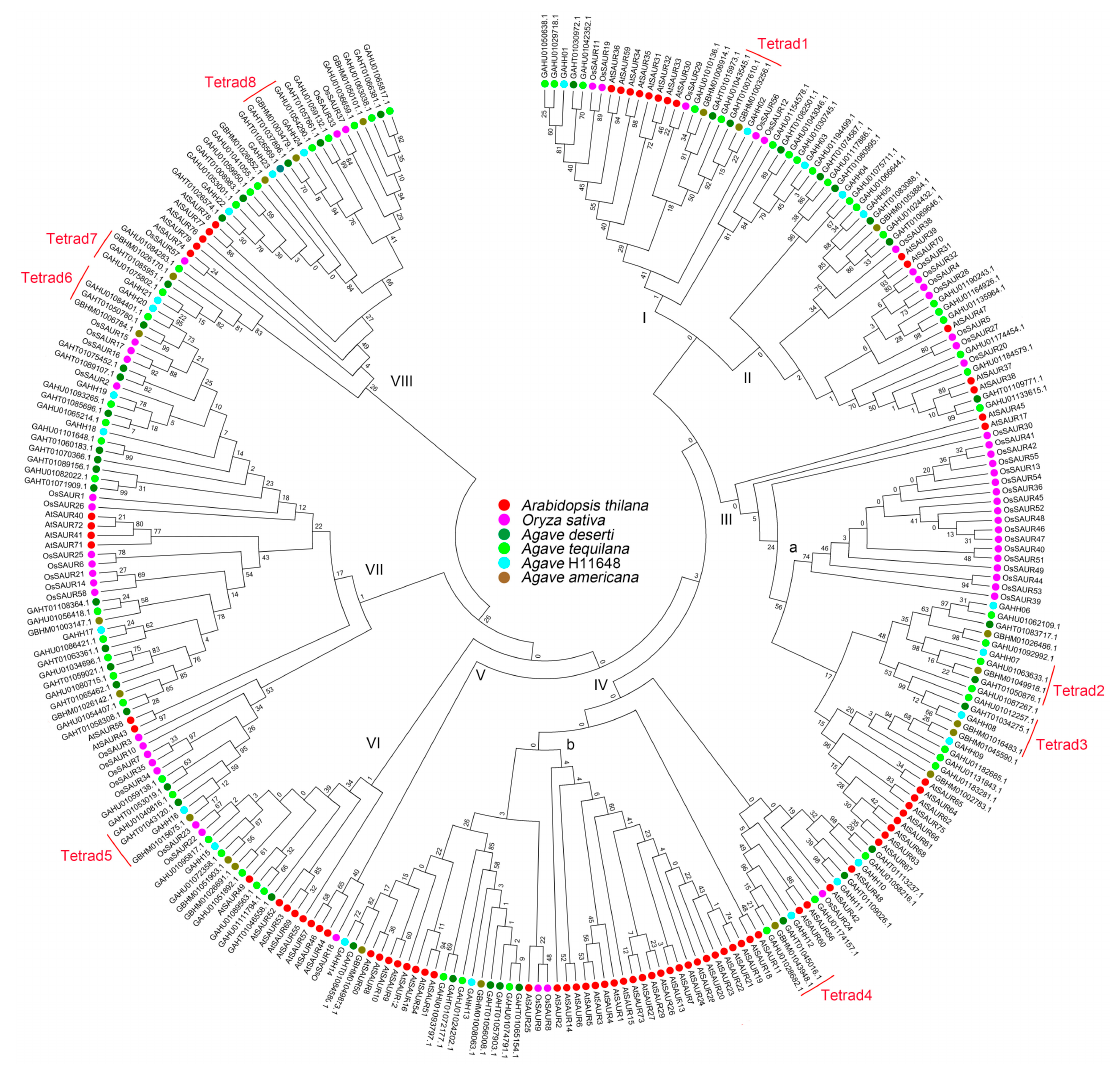
Figure 1. Phylogenetic tree of SAUR proteins from Arabidopsis (red), rice (pink), A. deserti (dark green), A. tequilana (green), A . H11648 (blue) and A. americana (brown). Agave homolog tetrads were highlighted in red. The species-specific expansion of SAUR genes was highlighted in rice (a) and Arabidopsis (b), respectively. Table 2. Numbers of rice and Agave SAUR genes in groups I-VII.